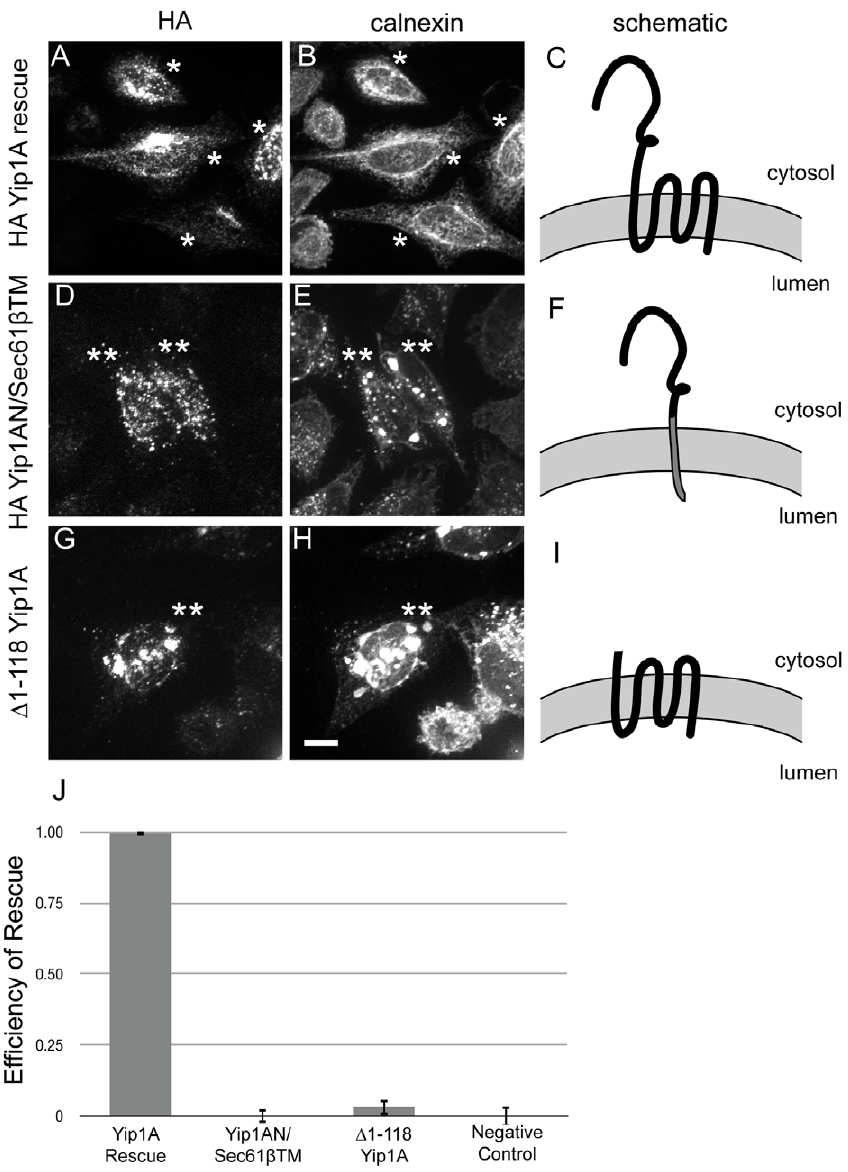
Figure 1. Both the cytoplasmic and TM domains of Yip1A are required to regulate ER whorl formation. HeLa cells were co-transfected with Yip1A siRNA and either a negative control myc-Sec61 b construct (not shown), a wild-type HA-Yip1A rescue construct (A–C), a chimeric construct (HA-Yip1AN/Sec61 b TM) with the N-terminus of Yip1A fused to the TM helix of Sec61 b (D–F), or a Yip1A truncation construct (HA-Yip1A D 1–118) lacking the entire cytoplasmic domain (G–I). Cells were fixed 72 h after transfection and co-stained with antibodies against HA (A, D, G) or Myc (not shown) and calnexin (B, E, H). Single asterisks mark cells expressing the indicated construct that did not exhibit ER whorls; whereas double asterisks mark expressing cells that did exhibit ER whorls. Scale bar, 10 m m. The constructs are schematized (C, F, I). (J) The normalized efficiency of rescue by each variant was quantified as detailed in Materials and Methods. Data were from 3 independent experiments ( . 100 cells per experiment), 6 SD.